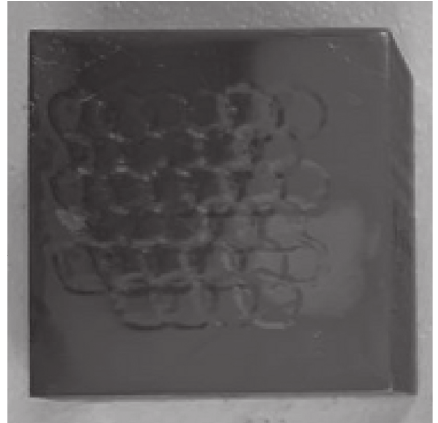
Figure 19: Morphology of sample of LSP.